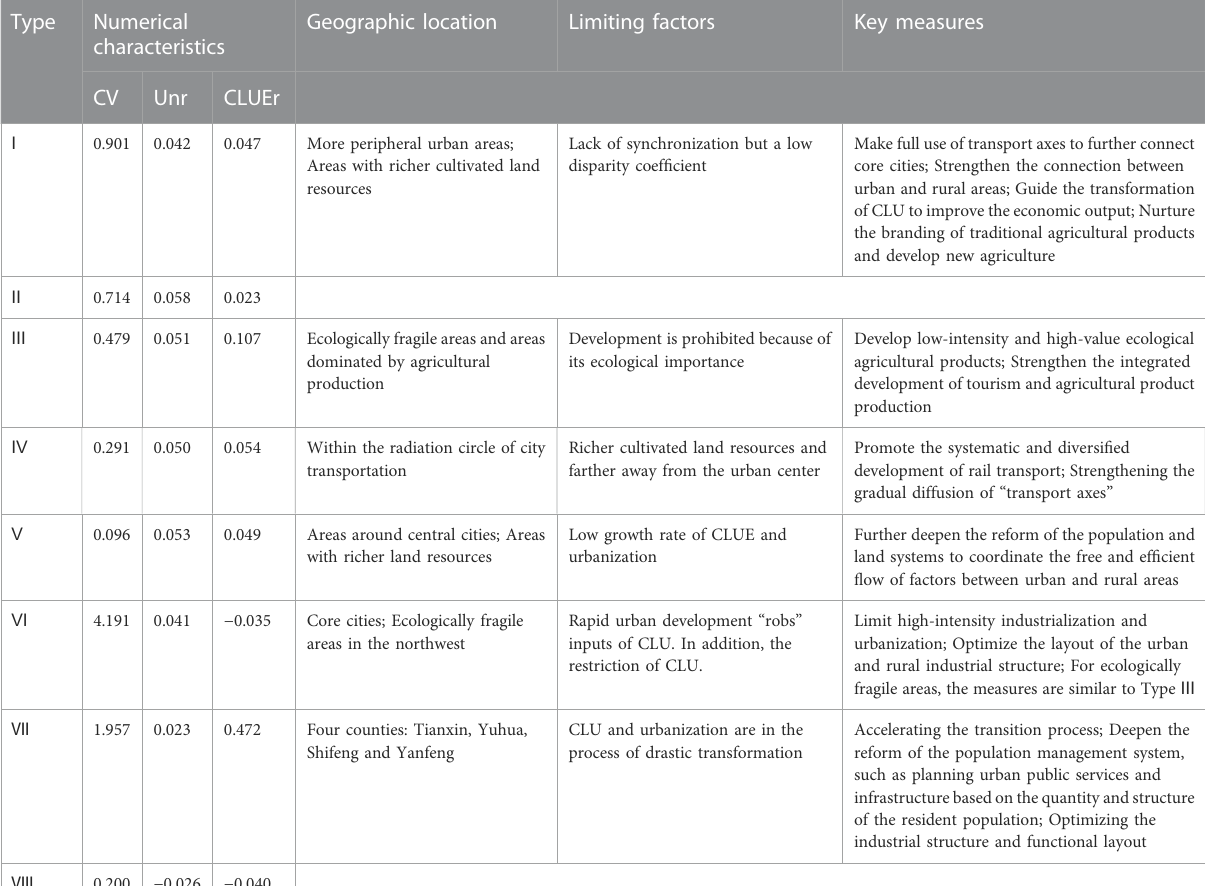
TABLE 6 Geographic location, limiting factors, and key measures of different UCLUC types. Type Numerical characteristics